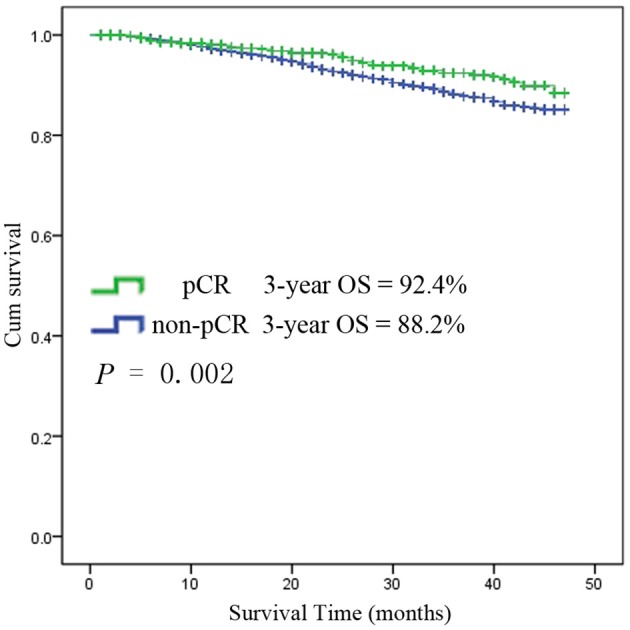
Kaplan-Meier survival curves for patients with and without pCR.